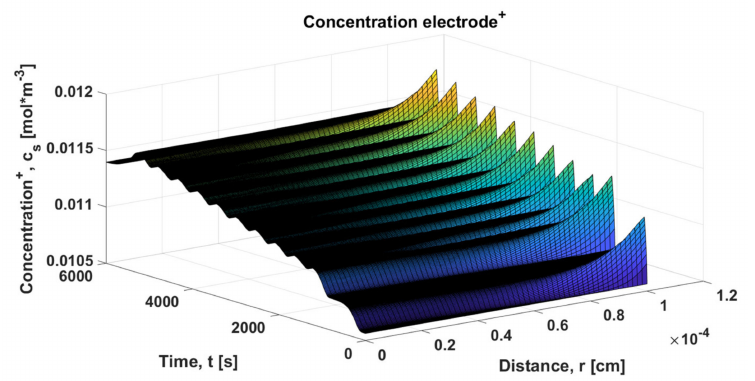
Figure 26. Li + concentration on the positive electrode.